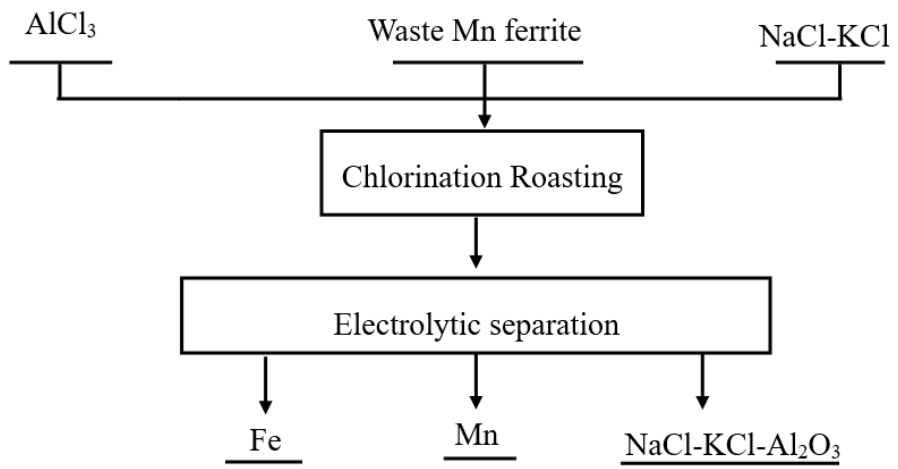
Figure 1. Flow diagram of a novel method for the utilization of waste Mn ferrite.